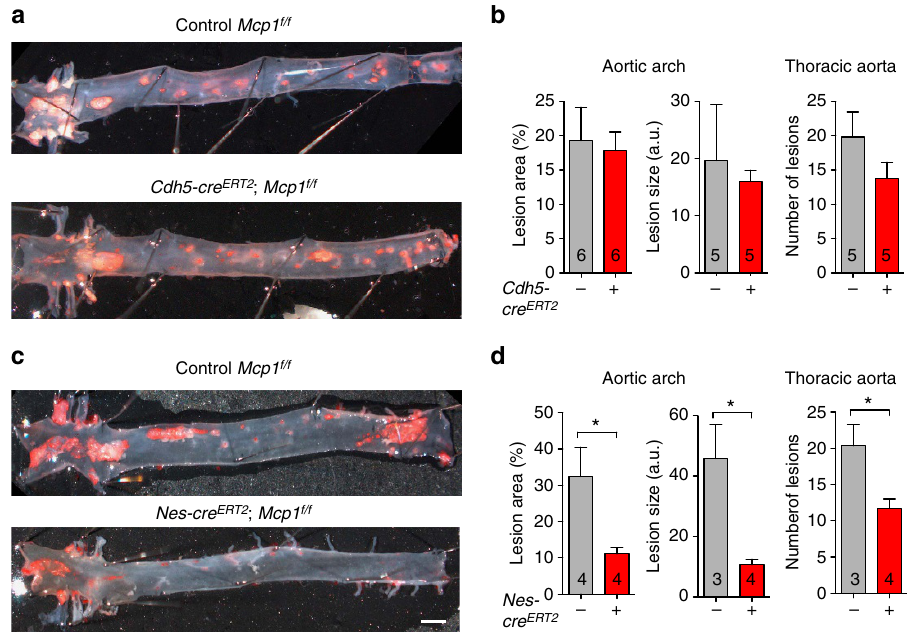
Figure 2 | Mcp1 deletion in nestin þ cells delays atherosclerosis progression. ( a , c ) Representative photographs of whole-mounted aortas from tamoxifen-treated ( a ) Cdh5-cre ERT2 ;Mcp1 f/f ; ApoE (cid:2) / (cid:2) mice, ( c ) Nes-cre ERT2 ;Mcp1 f/f ; ApoE (cid:2) / (cid:2) mice and control littermates (without Cre) two months after HFD, stained with Oil Red O (red) to mark atheroma plaques ( n ¼ 6). ( a , c ) Scale bar, 1mm. ( b , d ) Lesion size and coverage in the aortic arch (left) and number of lesions in the thoracic aorta (right) of these mice ( n ¼ 3–6). Data are means ± s.e.m.; n and P values are indicated; * P o 0.05, unpaired two-tailed t